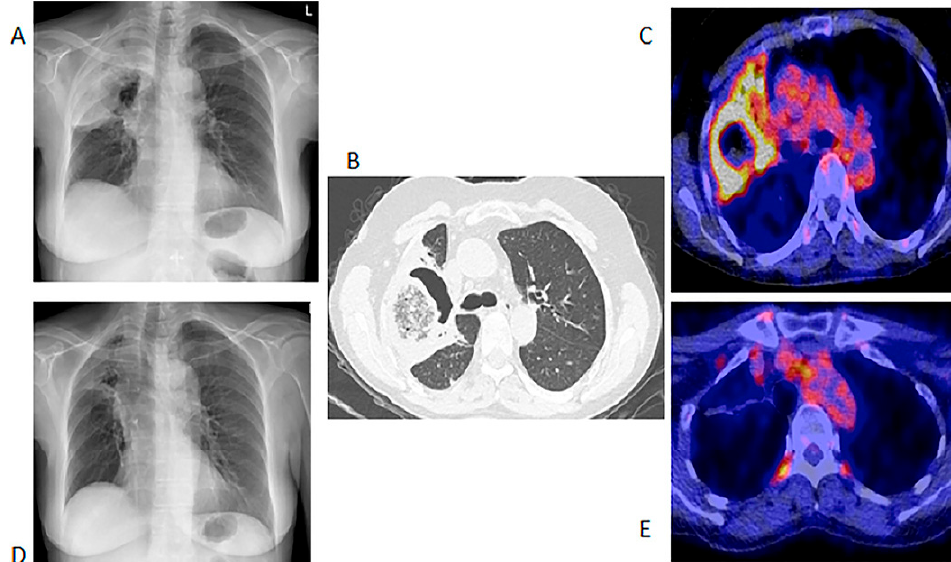
Figure 1. Chest X-ray, HR CT and [ 18 F]FDG PET/CT of a 60-year-old female with acute myeloid leukemia on chemotherapy. She had a proven fungal infection ( Alternaria alternata ). ( A )—Initial chest X-ray. ( B )—Initial HR CT scan performed before the [ 18 F]FDG PET/CT. ( C )—Fused axial image of [ 18 F]FDG PET/CT of the chest. After 2 months of antifungal therapy. ( D )—Chest X-ray showing response with a residual lesion. ( E )—Fused axial [ 18 F]FDG PET/CT showing an almost complete metabolic response in the IFI lesion. The data provided by [ 18 F]FDG PET/CT at follow-up were deemed adequate, so patient did not require a repeat HR CT.